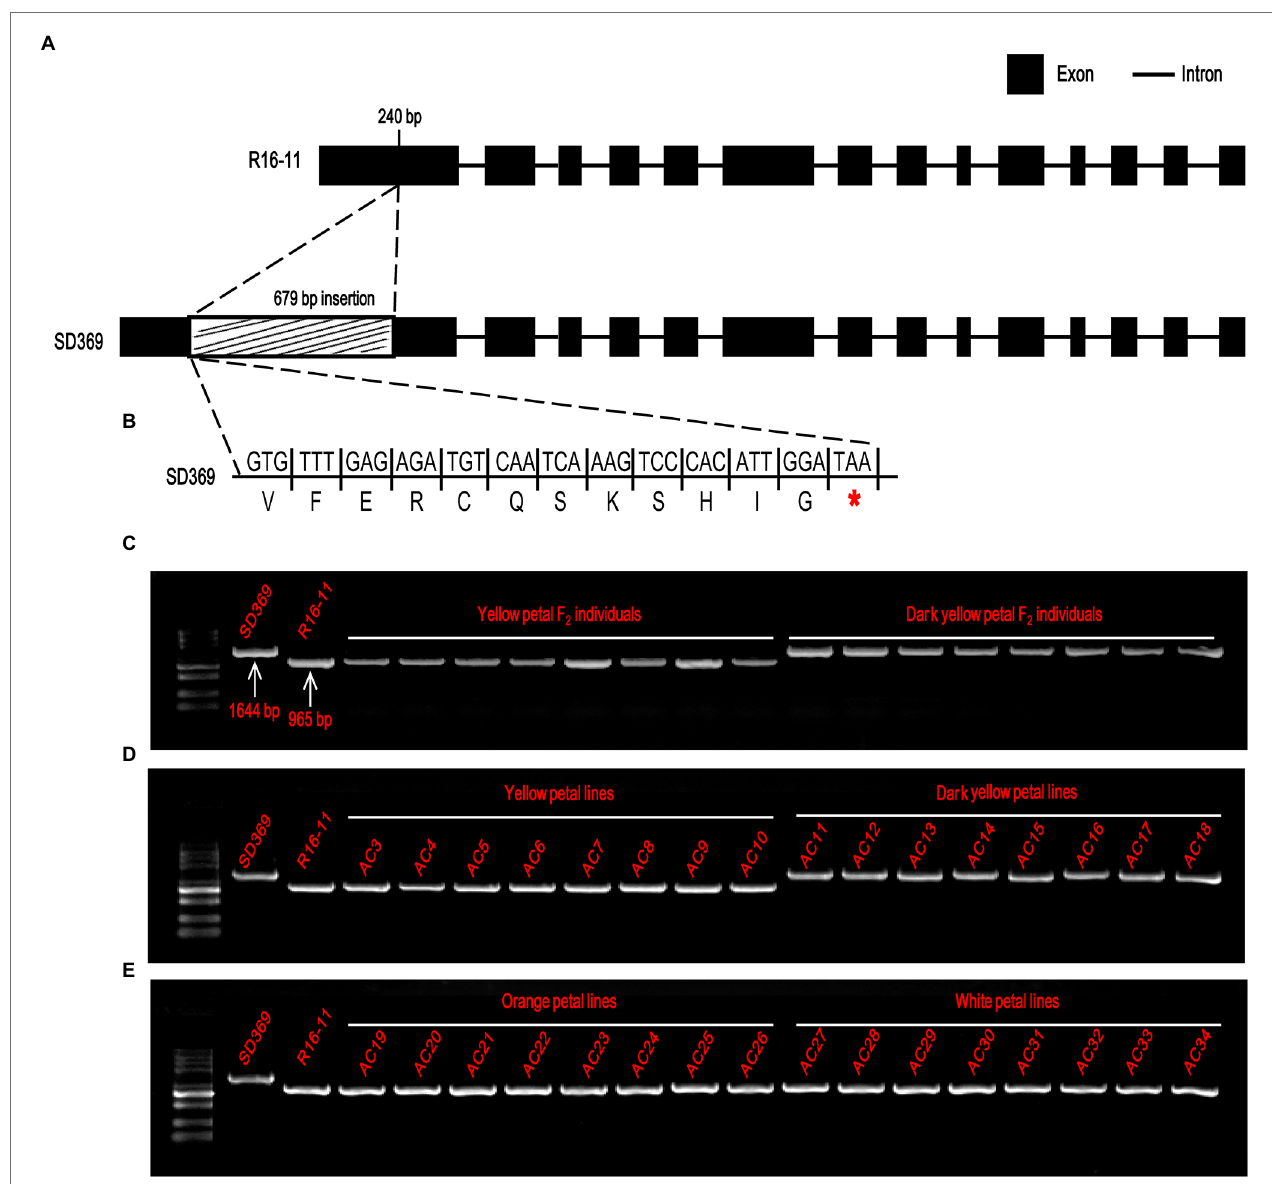
FIGURE 5 | Candidate gene analysis of Br-dyp1 . (A) Br-dyp1 includes 14 exons and 13 introns in the two parents. (B) A 679-bp insertion in dark-yellow-flowered SD369 caused a premature stop codon. (C–E) Validation of the functional marker Br-dyp1-InDel in F 2 individuals (C) , in 8 yellow and 8 dark-yellow-flowered materials (D) , and in eight orange and eight white flowered materials (E)